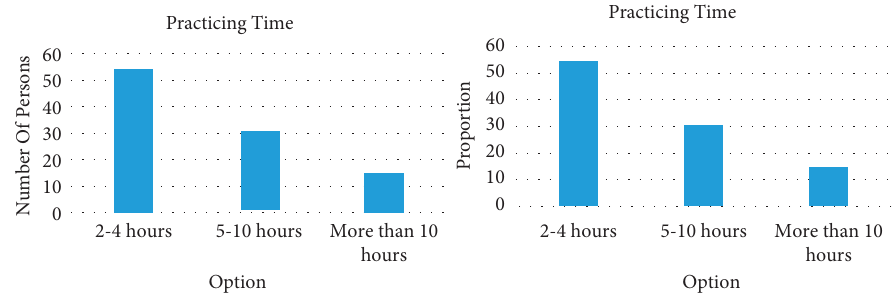
Figure 4: Survey and statistics of students’ weekly practice